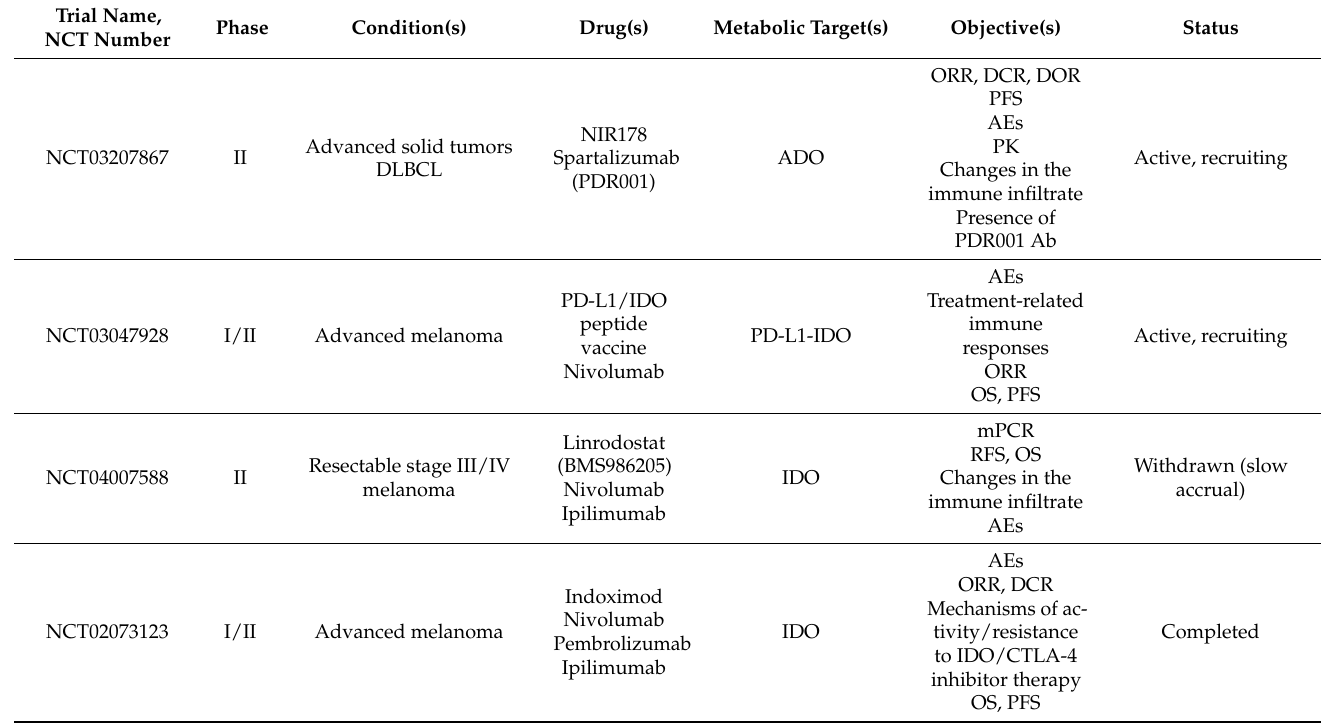
Table 1. Overview of the main active and recently concluded clinical trials of drugs targeting tumor metabolism in melanoma (source: clinicaltrials.gov; accessed on 17 April